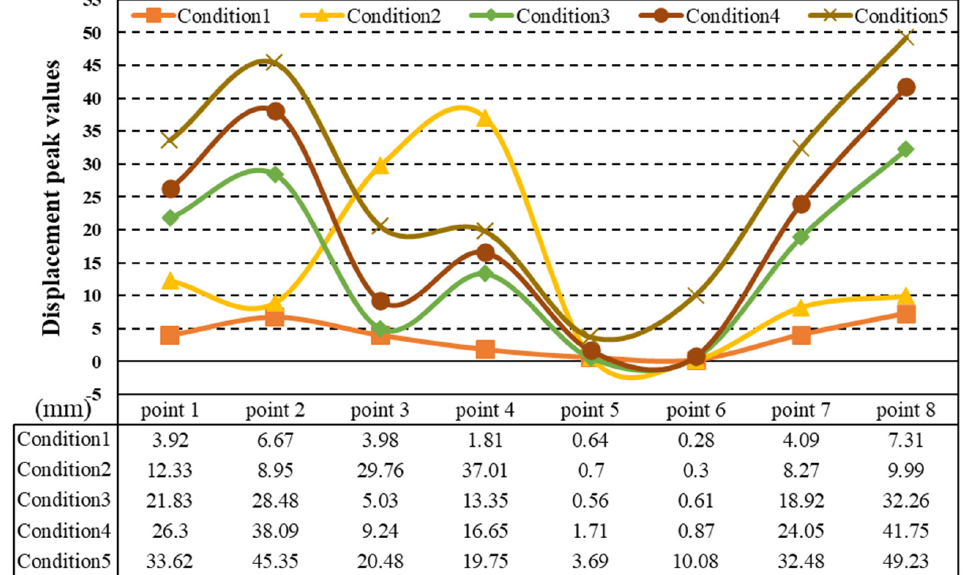
Figure 12. Displacement peak values of the points.